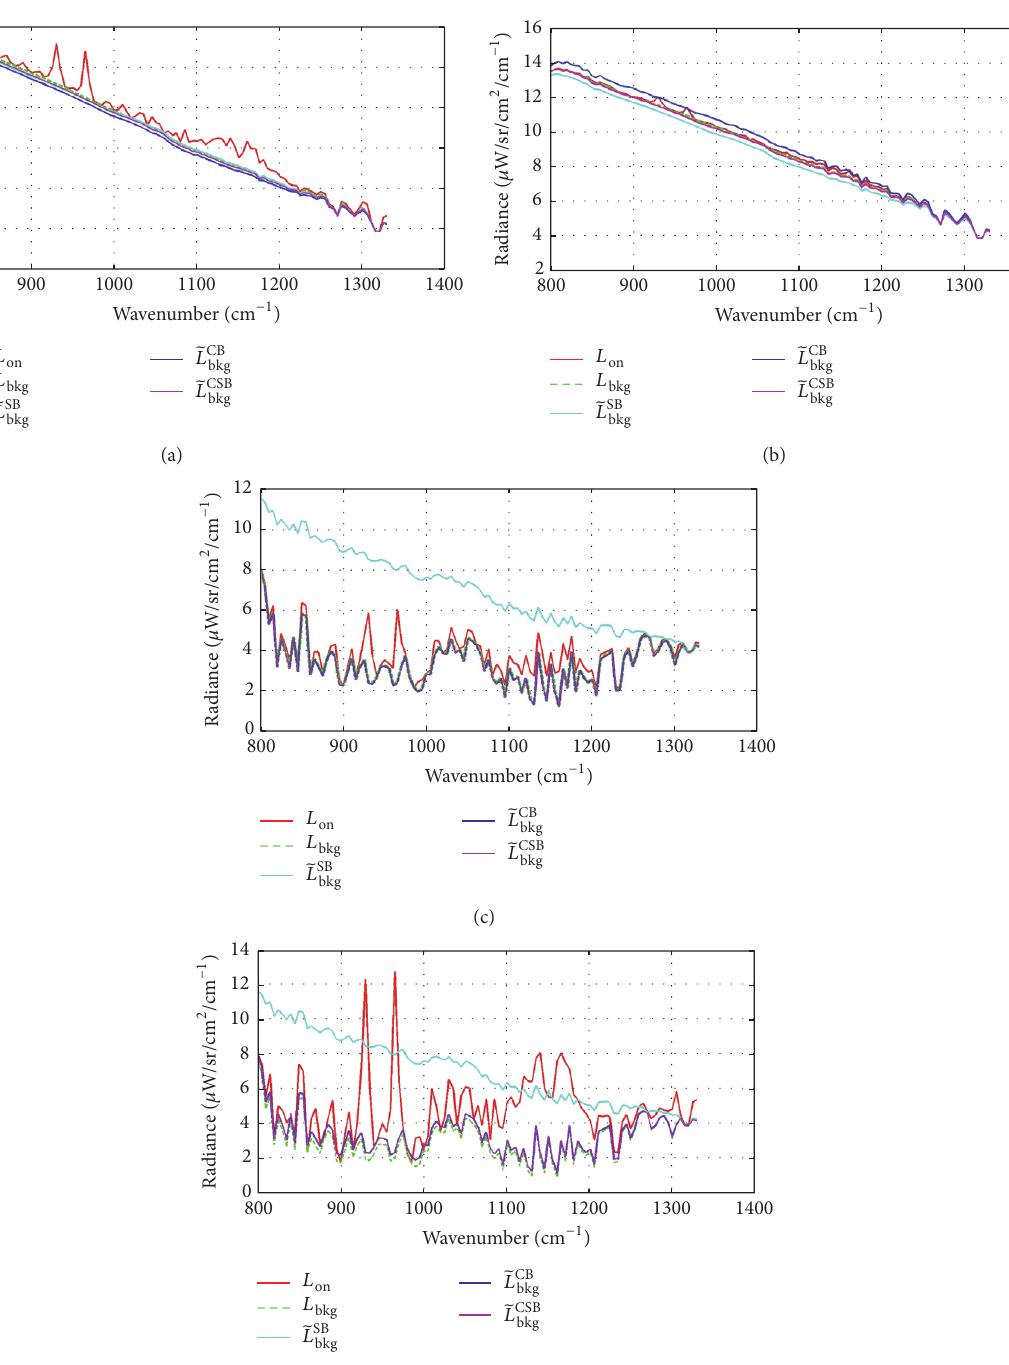
Figure 10: Comparison of background radiance estimation methods, for four different pixels through the plume. The red curves stand for the on-plume radiances; the dashed green ones are the real background radiances. The cyan, blue, and magenta curves represent, respectively, the background radiance estimated by the SB, CB, and CSB methods. (a) Results for pixel 1 (brown sandy loam), (b) results for pixel 2 (asphalt), (c) results for pixel 3 (aluminum), and (d) results for pixel 4